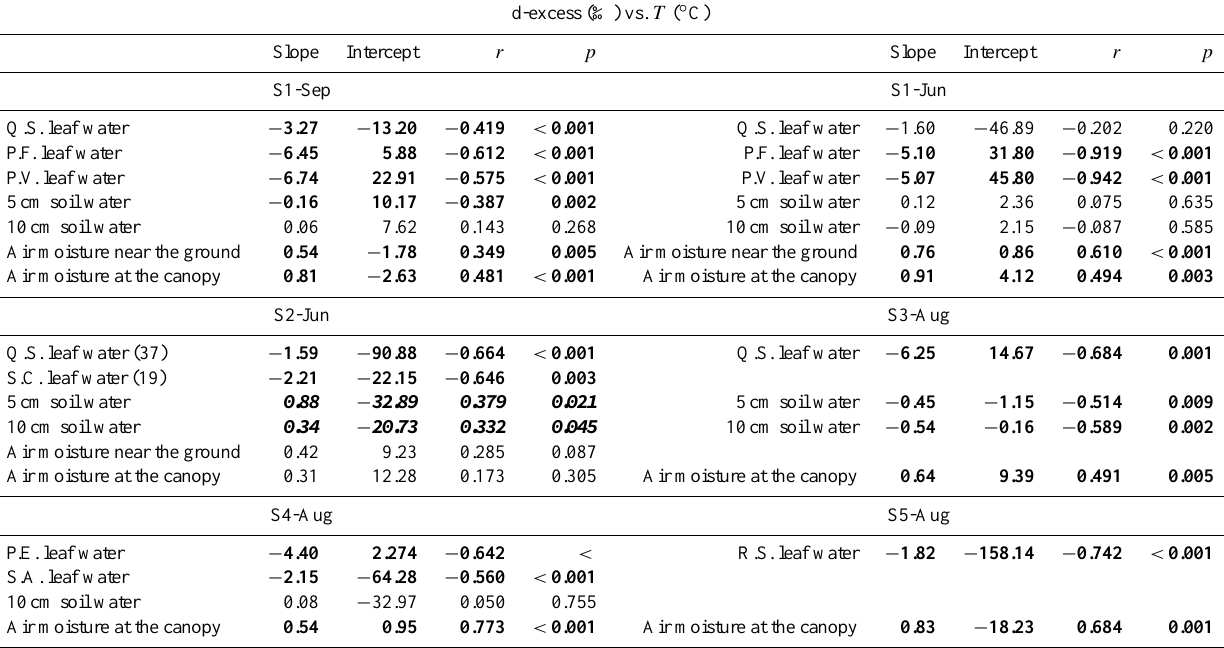
Table 8. Linear least square fits between the d-excess of various water bodies and the temperature ( T ) ( ◦ C) at each site. Here, r is the correlation coefficient, and p is the significance level. p < 0.001 indicates statistical significance at the 99.9% significance level, and p < 0.05 indicates statistical significance at the 95% significance level. The location ID and the abbreviations of plant Latin names are the same as in Tables 2 and 3.